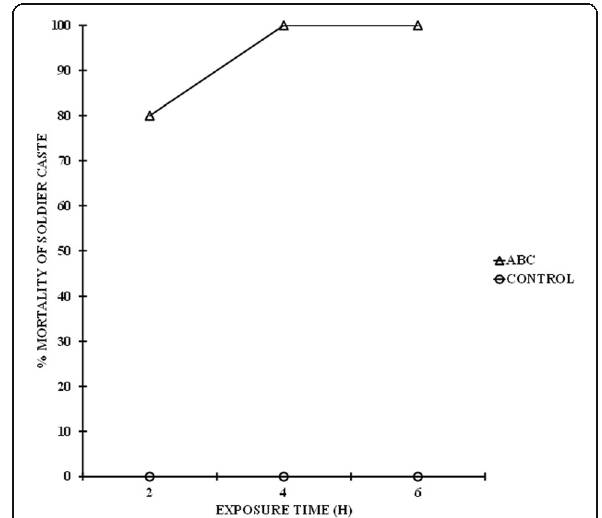
Fig. 4 Percentage mortality of soldier caste Macrotermes subhyalinus (worker) on filter paper treated with tri-mixed aqueous extract. ABC = Azadirachta indica plus Nicotiana tabacum plus Jatropha